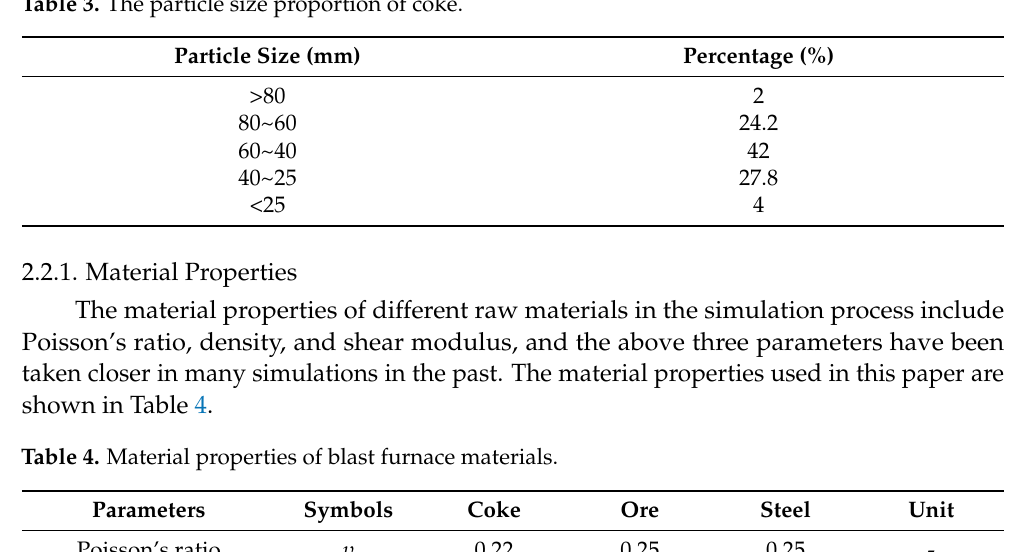
Table 3. The particle size proportion of coke.